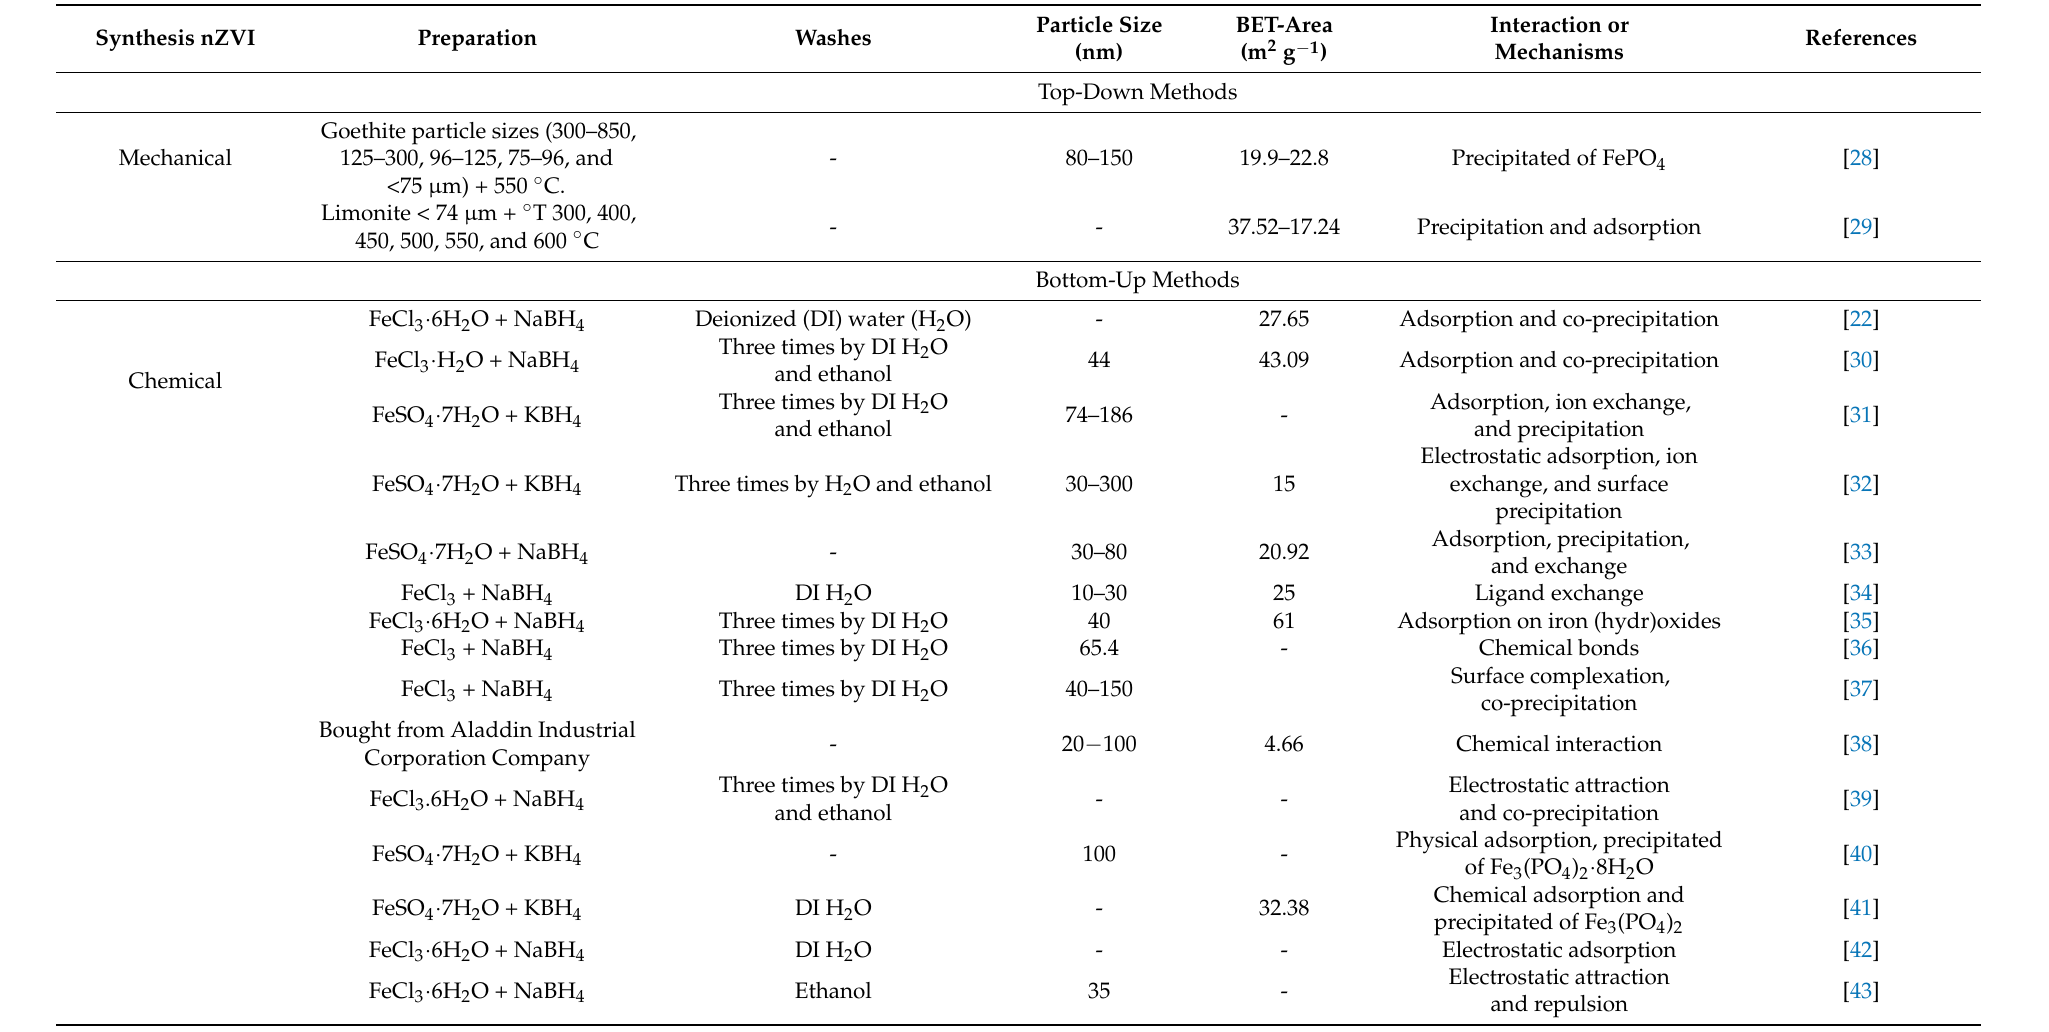
Table 1. Synthesis and properties of nZVI and mechanisms involved in phosphate